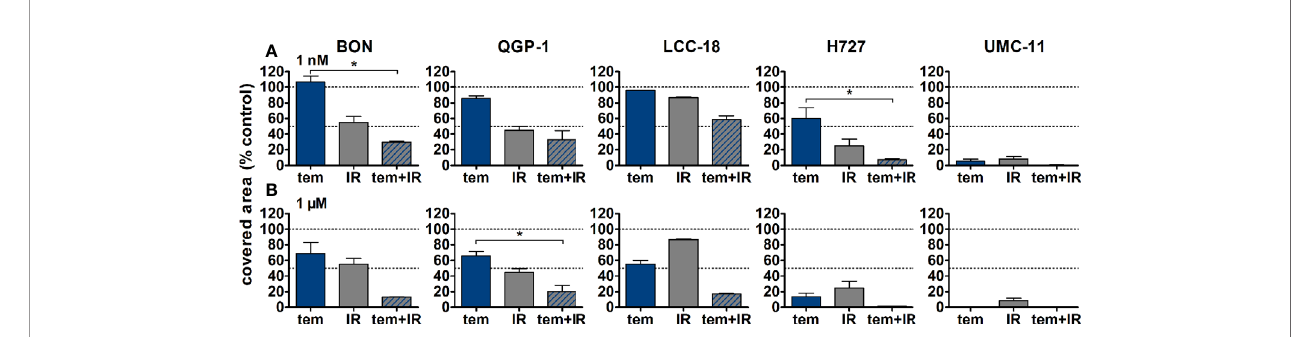
FIGURE 9 | Detailed analysis of cell survival for combined treatment of temsirolimus and 4 Gy. NEN cell lines were pretreated with 1 nM (A) or 1 µM (B) temsirolimus for 24 h before irradiation with 4 Gy. Cell survival was determined 1 – 2 weeks after irradiation. Graphs show mean ± S.E.M. (n=2 – 3). Evaluated with one-way ANOVA (Kruskal-Wallis test) and Dunn ’ s posttest, *P ≤ 0.05. tem, temsirolimus; IR, irradiation.